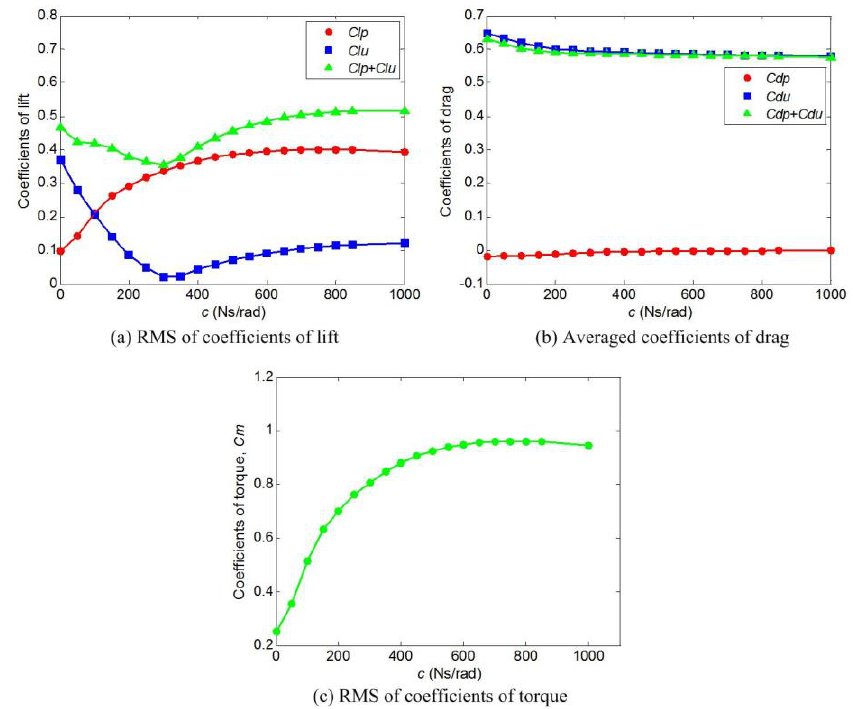
Figure 11. Effects of damping on ( a ) lift, ( b ) drag, and ( c ) torque.